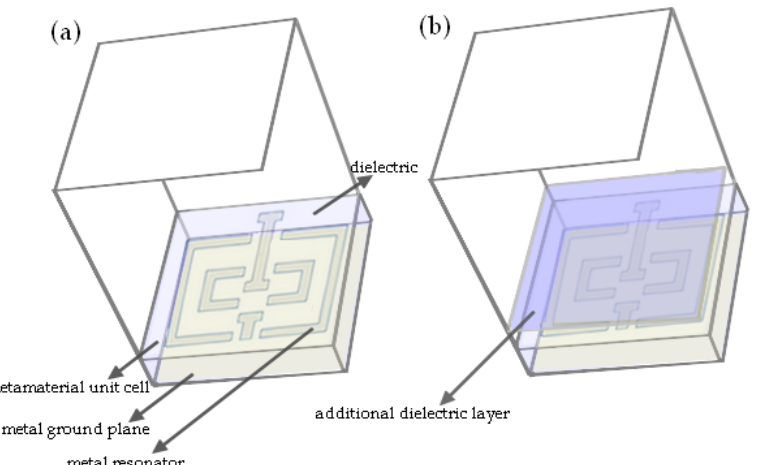
Figure 4. Simplified (single element) structure of the metasurface model: ( a ) proposed metasurface structure; ( b ) proposed metasurface structure with very thin additional dielectric layer.